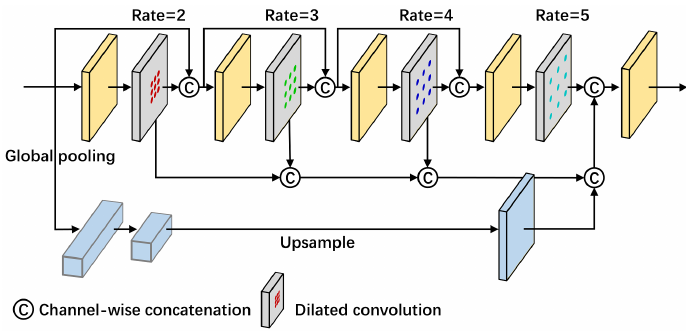
Figure 6. Framework of feature enhancement feature pyramid (FEFP) module.